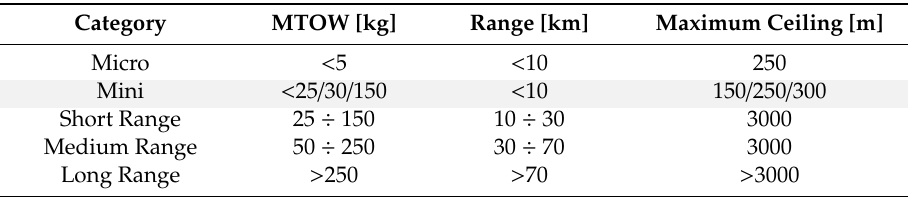
Table 1. International classification of unmanned aerial vehicles (UAVs) [13].